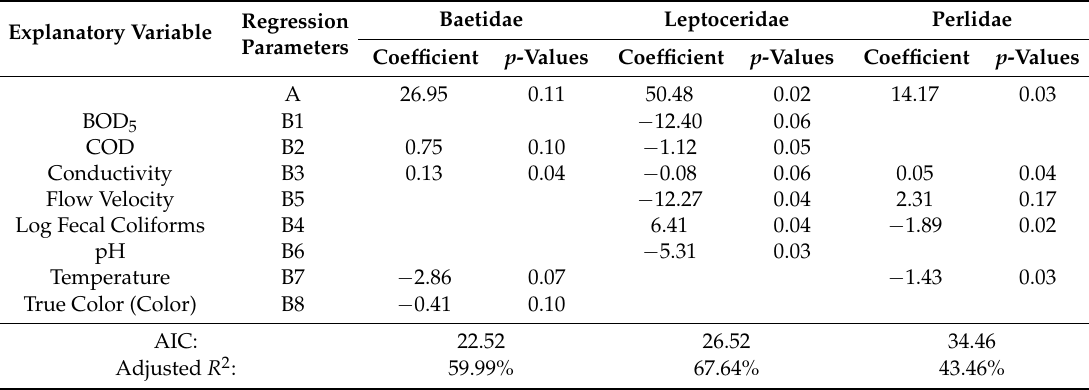
Table 3. Regression parameters: p -values and goodness-of-fit measurements of the models for predicting the presence of Baetidae , Leptoceridae and Perlidae